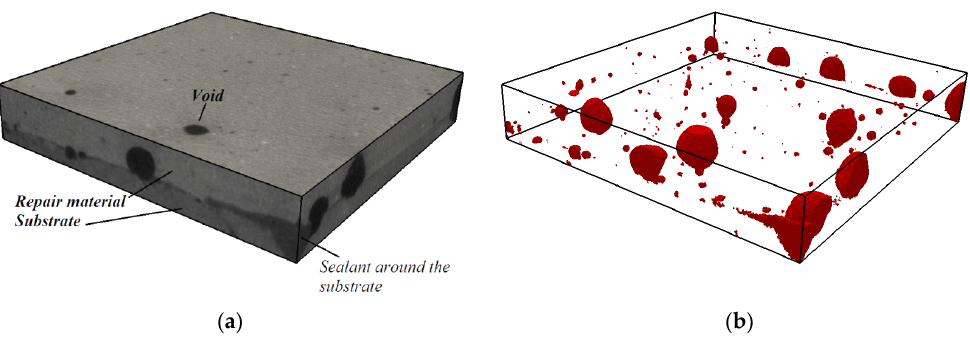
material (Figures 13a and 16). A void from the substrate is continuing in the repair material, making